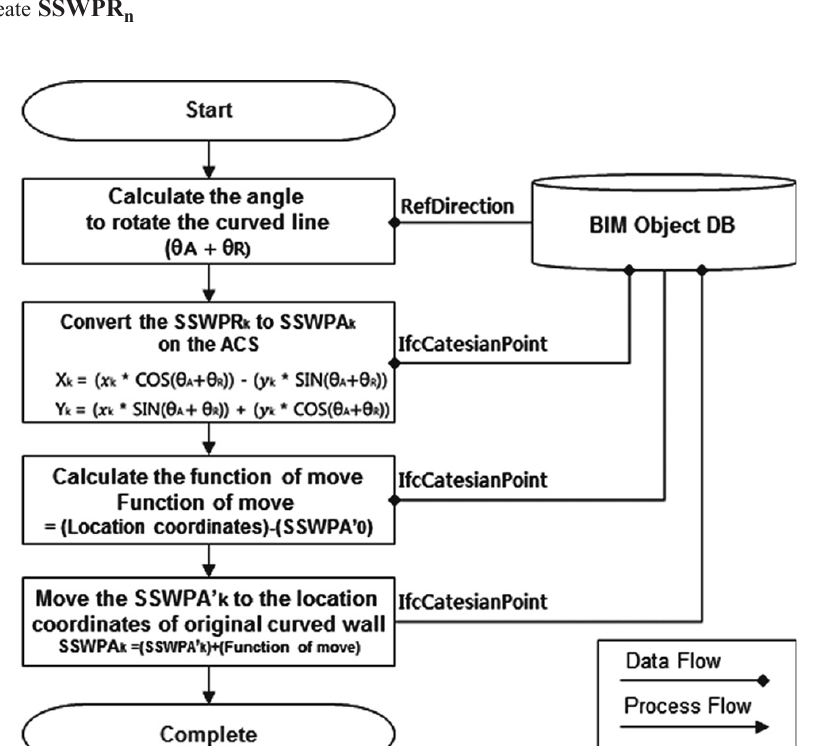
Fig. 7. Process of SSWPA